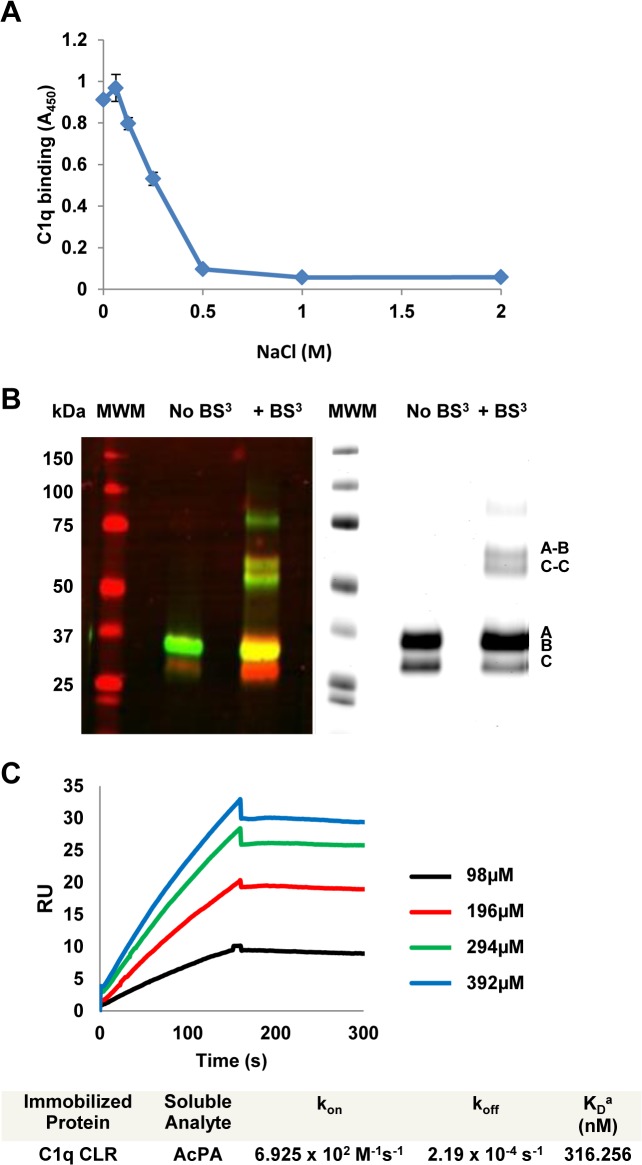
PA interacts with C1q in a salt-sensitive manner and specifically binds the C1q CLR.(A) The AcPA peptide was adsorbed to a microtiter plate and incubated with a constant amount of C1q in the presence of varying amounts of NaCl. Bound C1q was detected with a goat polyclonal anti-C1q sera followed by HRP-conjugated anti-goat sera. Data represent the means of three independent experiments. Error bars denote SEM. (B) C1q and biotinylated PA in the absence or presence of the crosslinker BS3 were loaded onto a 4–12% SDS-PAGE gel, (left panel) transferred to nitrocellulose and probed with antibody to detect C1q (green) and streptavidin conjugate to detect PA (red). An identical gel was stained with bio-safe Coomassie blue, and visualized by Odyssey imaging (right panel). Molecular size markers (in kDa) are indicated to the left and chains of C1q (A, B, C, A-B, C-C) are indicated to the right. (C) Interactions between AcPA and the CLR of C1q as measured by surface plasmon resonance (SPR). The CLR of C1q was immobilized onto the surface of a dextran sensor chip and AcPA was injected at the indicated concentrations. Data analysis consisted of globally fitting the SPR sensorgrams for different peptide concentrations with a 1:1 model taking into account mass transport. KD values were calculated from koff/kon for each experiment and were averaged from at least two separate experiments.